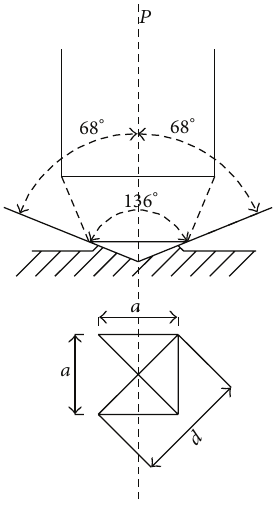
Figure 1: Head shape and principle of HV tester.